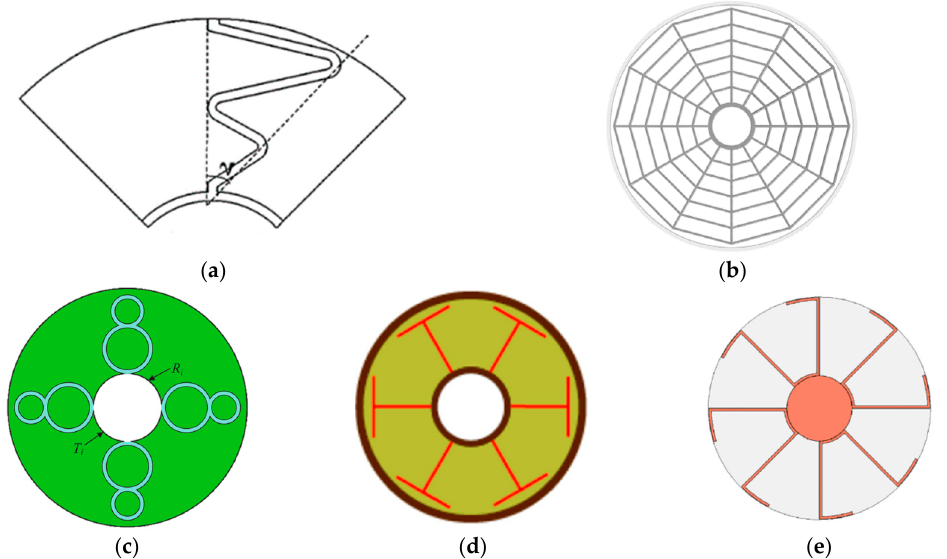
Figure 13. Different innovative fins. ( a ) Longitudinal corrugated fin [112]; ( b ) Spiderweb-like fin [113]; ( c ) Circular superimposed longitudinal fin [114]; ( d ) T-shaped fin [115]; ( e ) Blossom-shaped fin [116]. (Permission to reproduce from Refs.